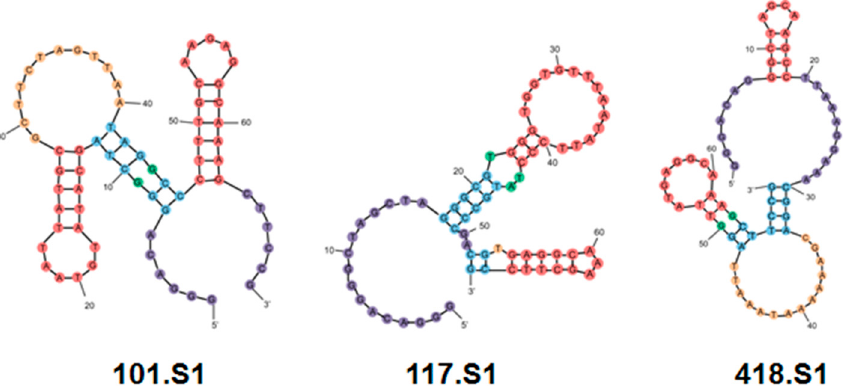
Figure 1. Schematics of three members of self-hybridized AuNR aptamer sequences, namely, 101.S1, 117.S1, and 418.S1 of SSF2. As shown in Table 1, each member of SSF2 possesses two single-stranded segments (purple); two hairpin stem / loops (red); one internal loop (green); one bulge (yellow); two duplexes (blue); and zero multi-branched loops (dark pink).